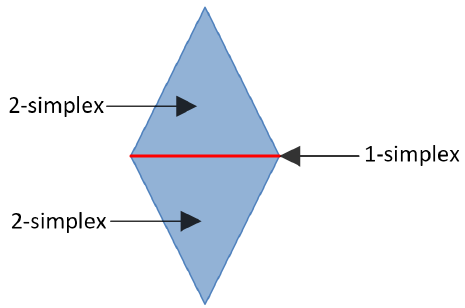
Figure 2. Two 2-simplices that share a segment (1-simplex) and form a 2-simplicial